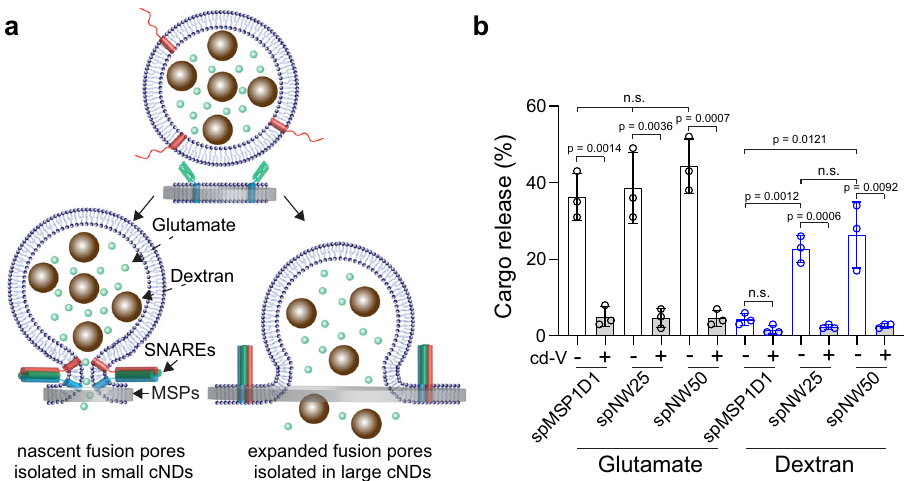
Fig. 5 Application of cNDs in the reconstitution of fusion pores. a Illustration of the reconstituted fusion pores in small and large nanodiscs. b Quanti fi cation of glutamate and fl uorescent dextran release from fusion pores reconstituted using the indicated MSPs. Data are shown as mean±s.d., n = 3 independent experiments. Statistics were determined using a two-tailed t -test. n.s., not signi fi cant. Source Data are available as a source data fi le.